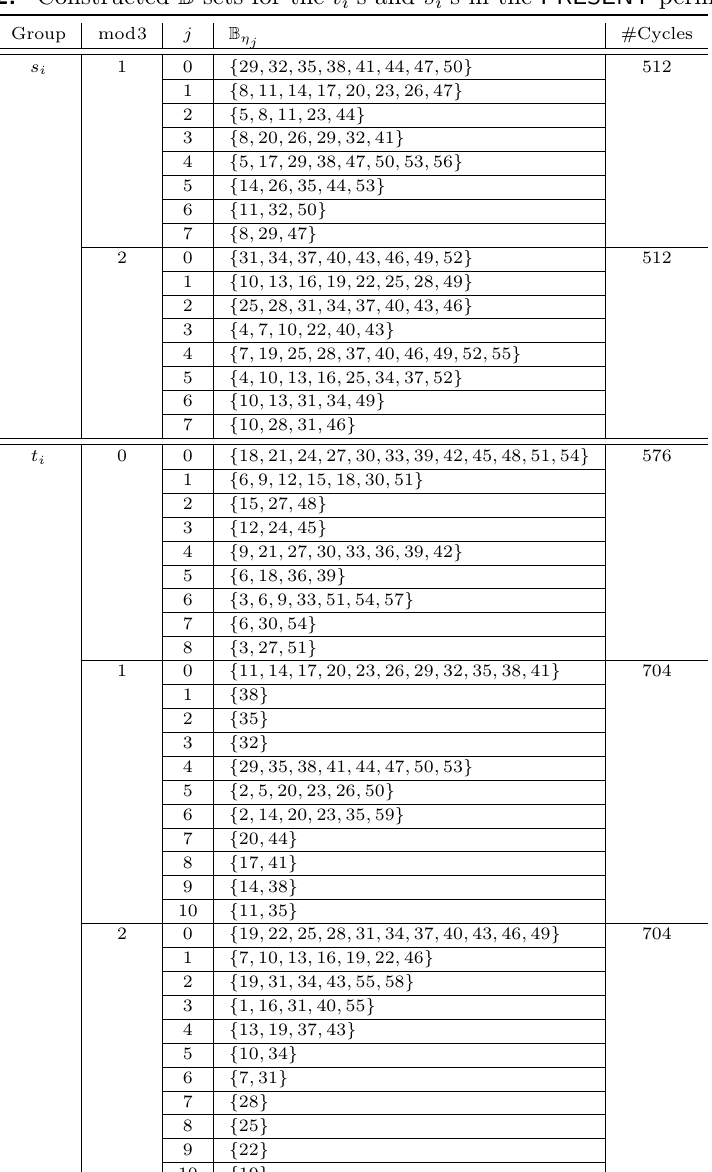
Table 12: Constructed B sets for the t i ’s and s i ’s in the PRESENT